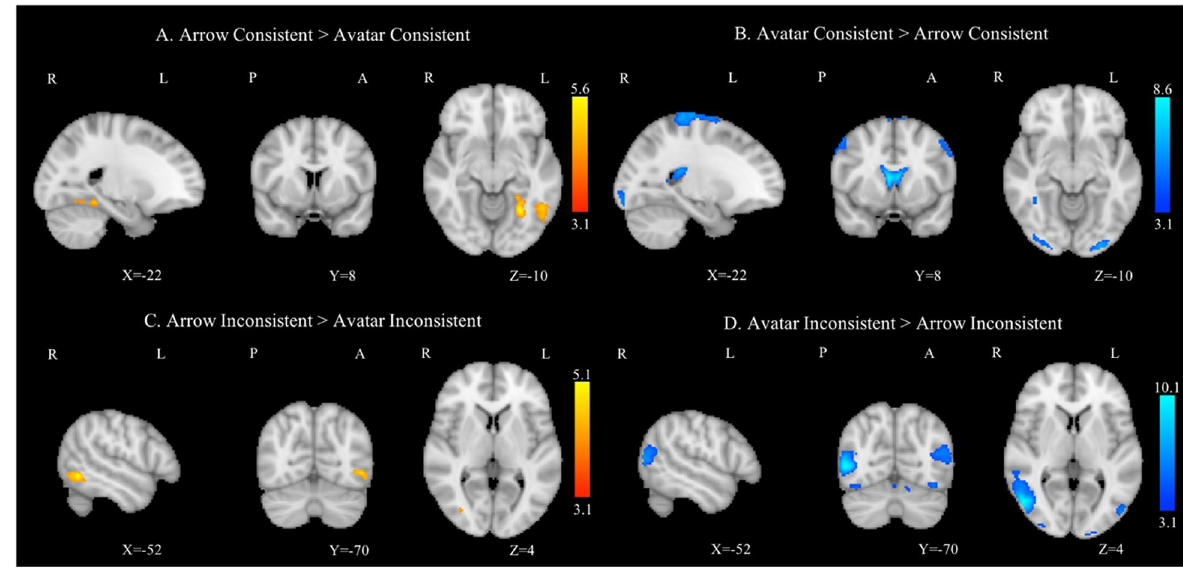
The comparison "Arrow Consistent versus Avatar Consistent" showed increased activation confined to the left lateral occipital and fusiform cortices. The inverse contrast generated an activation that concerned not only bilateral precentral gyrus, lateral occipital cortex and occipital pole but also the right fusiform cortex, right supe- rior frontal gyrus and frontal pole (Fig. 4A,B). In the same line, the contrast "Arrow Inconsistent versus Avatar Inconsistent" revealed increased activation in the right lateral occipital cortex and the left inferior temporal gyrus. The inverse comparison displayed fMRI activation in the bilateral lateral occipital cortex, the left fusiform cortex and occipital pole, as well as the left frontal pole and paracingulate gyrus (Fig. 4C,D).